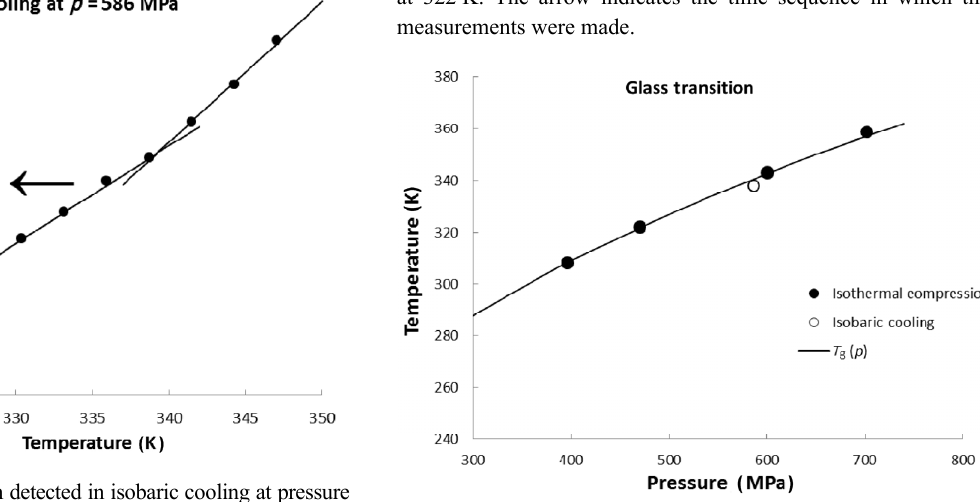
Fig. 3 The glass transition temperature as a function of pressure and the correlation of Oelsand